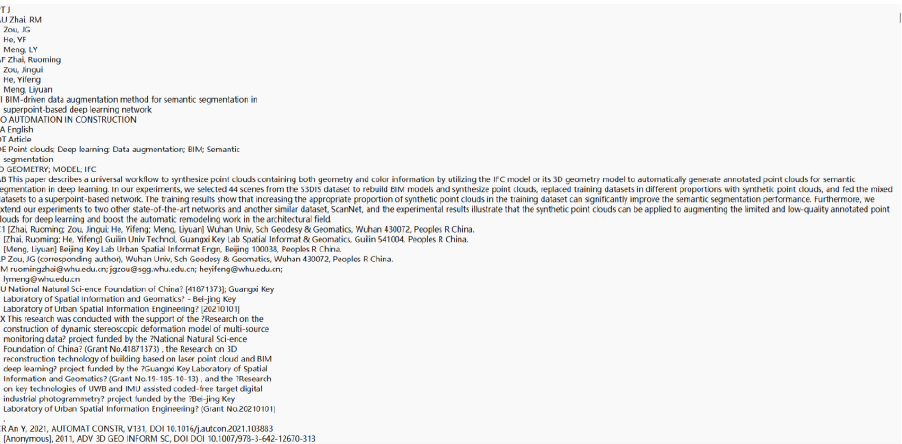
Figure 3. A bibliography document showing the detailed information of a qualified paper exported from WoS. from